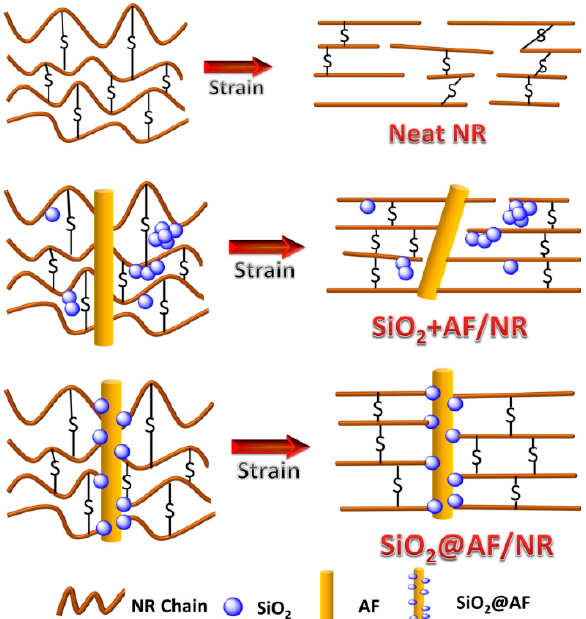
Figure 9. Molecular orientation under tensile strain of the pure NR and the SiO 2 + AF / NR and SiO 2 @AF / NR composites.